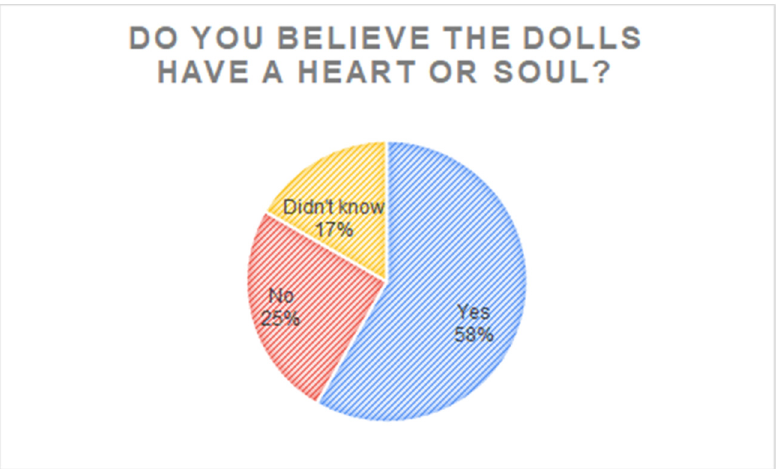
Figure 2. Responses on whether the doll owners believed the dolls have a heart or soul (Source: Prepared by the authors).